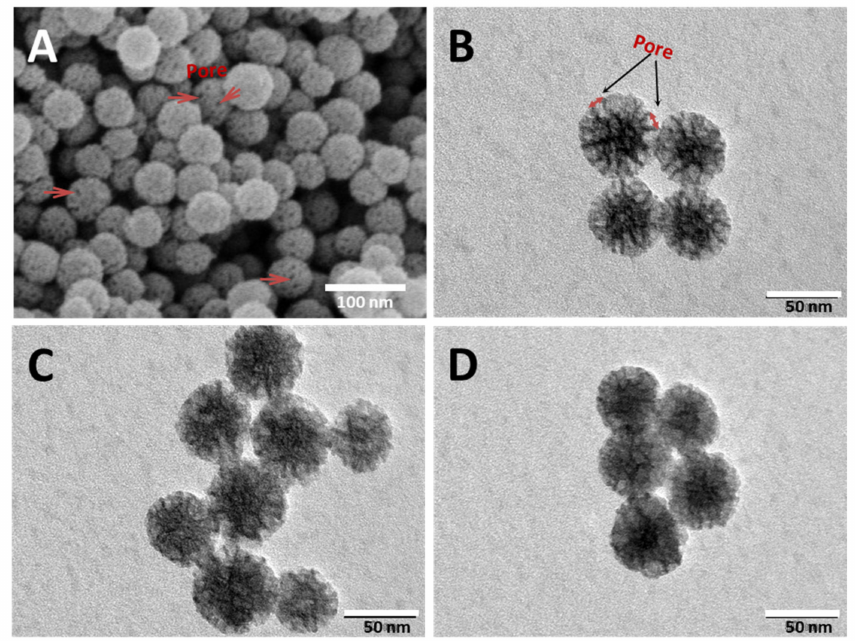
Figure 1. SEM photographs of mesoporous silica nanoparticles (MSNs) ( A ) and TEM photographs of